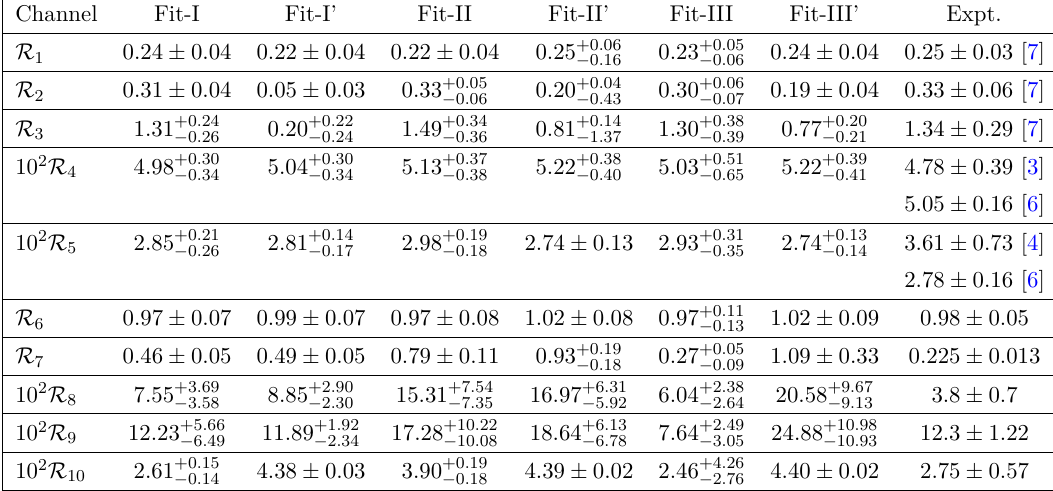
Table 10 . Predictions of ratios between branching fractions in different schemes, in which the definition of R are given in table i